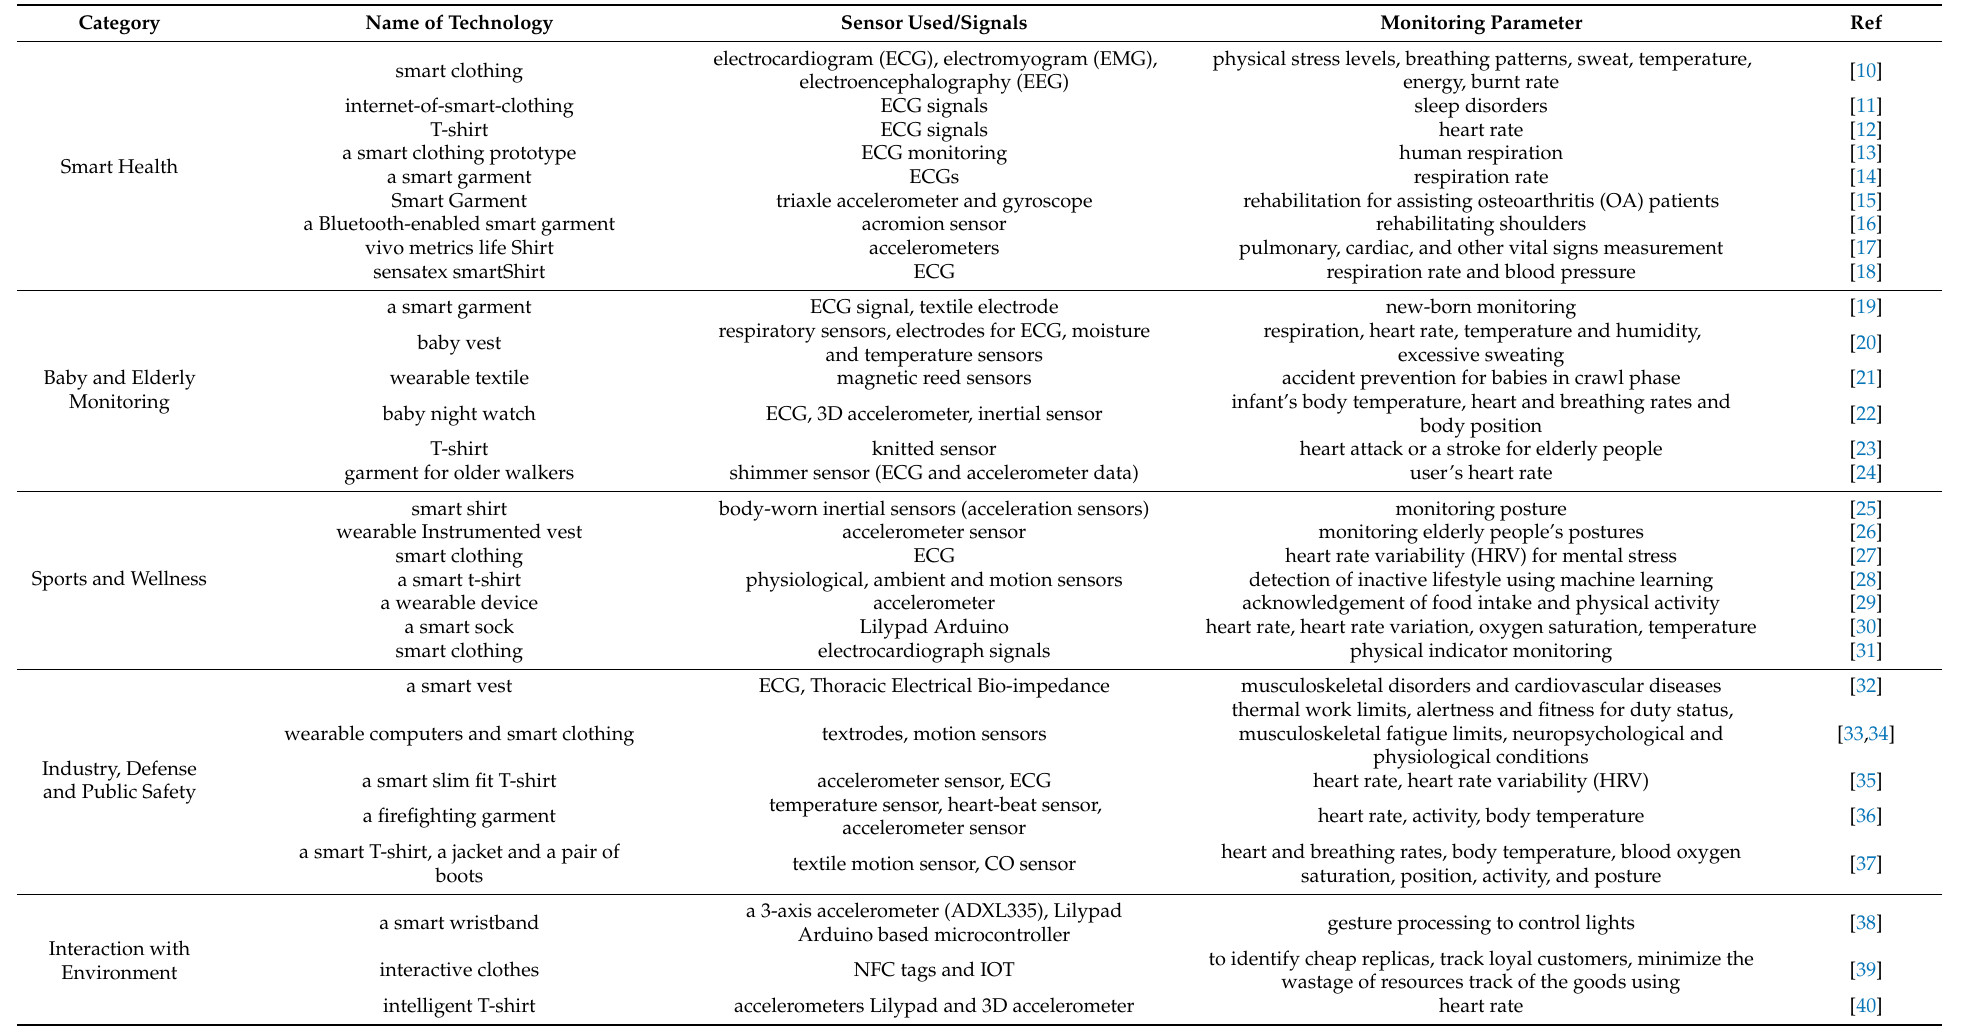
Table 1. Examples of the current development of smart clothing in